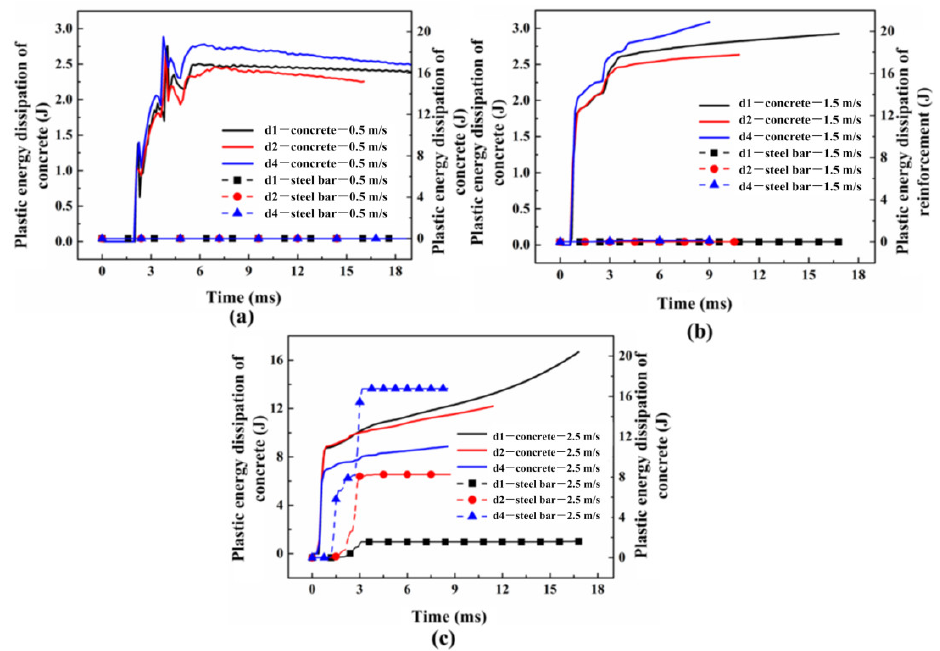
Figure 18. The plastic dissipation for concrete and steel bars when impact velocity are ( a ) 0.5 m/s; ( b ) 1.5 m/s; and ( c ) 2.5 m/s.